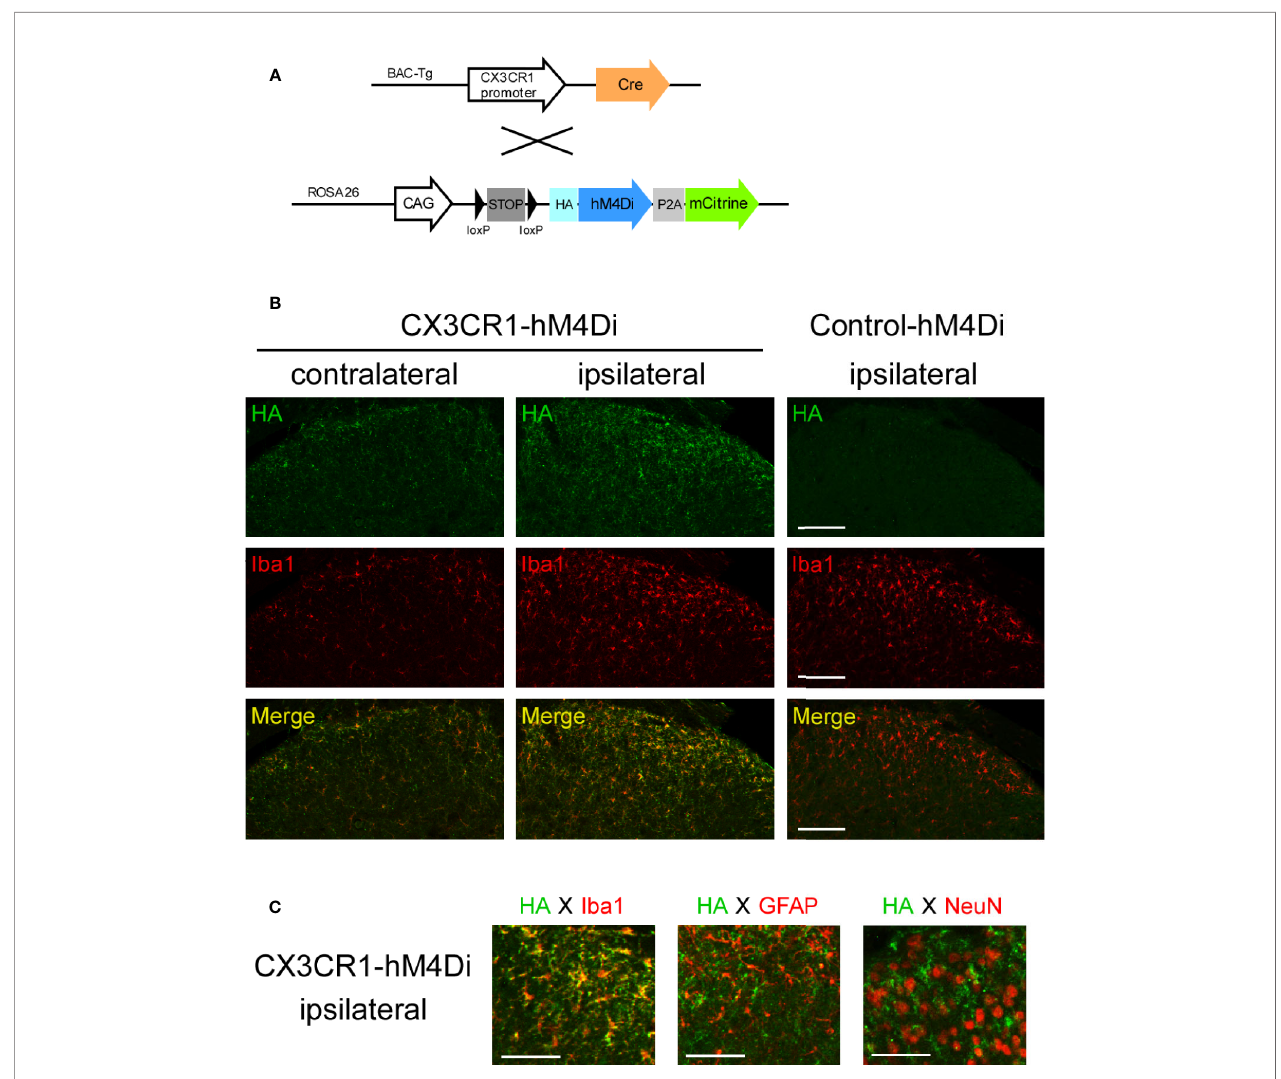
FIGURE 1 | hM4Di expression in spinal microglia of CX3CR1-hM4Di mice. (A) Scheme of Cre-dependent expression of hM4Di in CX3CR1 + cells by crossing CX3CR1-Cre (Tg) mice with R26-LSL-hM4Di-DREADD mice (Control-hM4Di). Following Cre-mediated removal of an upstream fl oxed-STOP cassette, the HA-tagged hM4Di and mCitrine were expressed in CX3CR1 + cells. (B, C) The mice were subjected to partial sciatic nerve ligation (PSL), and the lumbar spinal cord (L4-5) was dissected on day 7 after PSL. Expression of HA-tagged hM4Di in the spinal dorsal horn (SDH) was visualized by immunohistochemistry. (B) Expression of HA- tagged hM4Di in the SDH of CX3CR1-hM4Di mice. Scale bars = 100 m m. (C) Localization of HA-hM4Di in Iba1 + microglia, but not GFAP + astrocytes or NeuN + neurons. Scale bars = 50 m